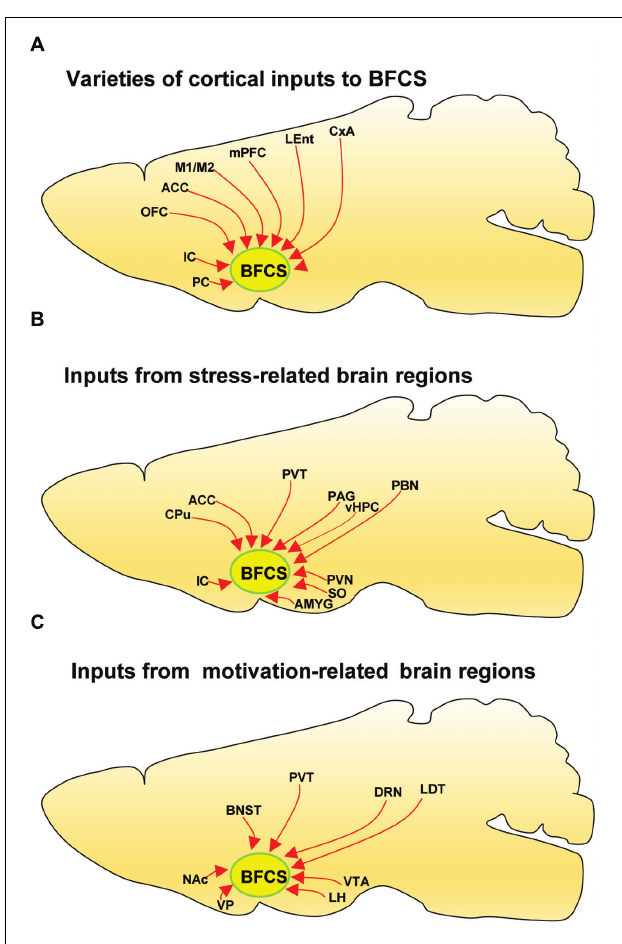
FIGURE 4 | Summarized connectivity of the BFCS. (A) Schematic summary of cortical inputs to the BFCS. (B) Schematic summary of inputs from stress-related brain regions to the BFCS. (C) Schematic summary of inputs from motivation-related brain regions to the